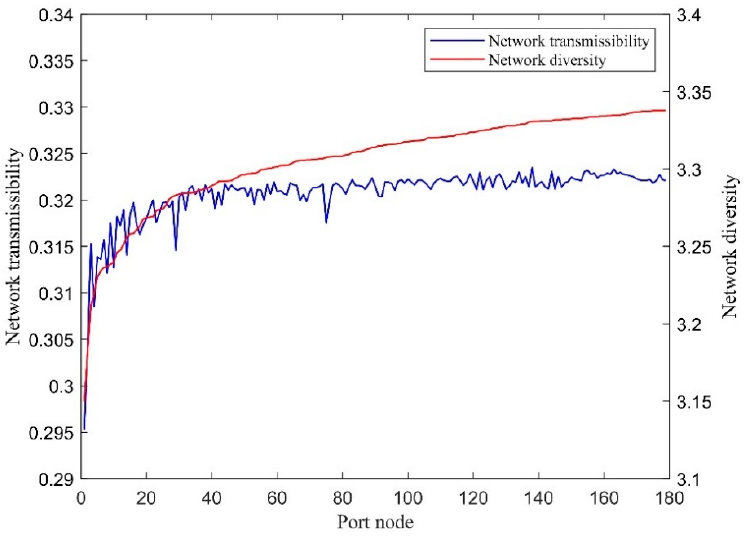
Figure 2. Network resilience when all port nodes individually fail in sequence.